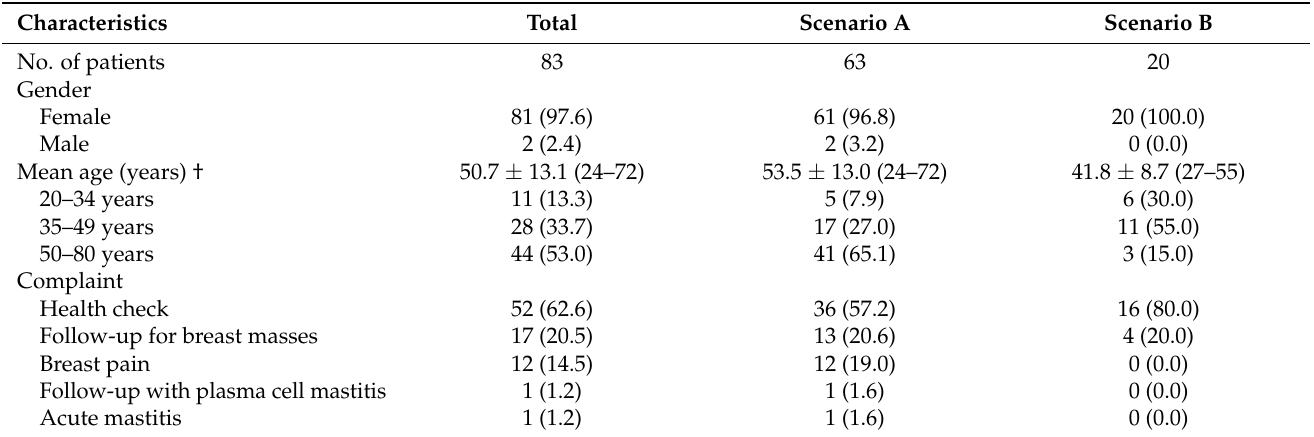
Table 1. Basic information of enrolled patients. Except where indicated, the data in parentheses are percentages. †: The data are expressed as means ± standard deviation, with ranges in